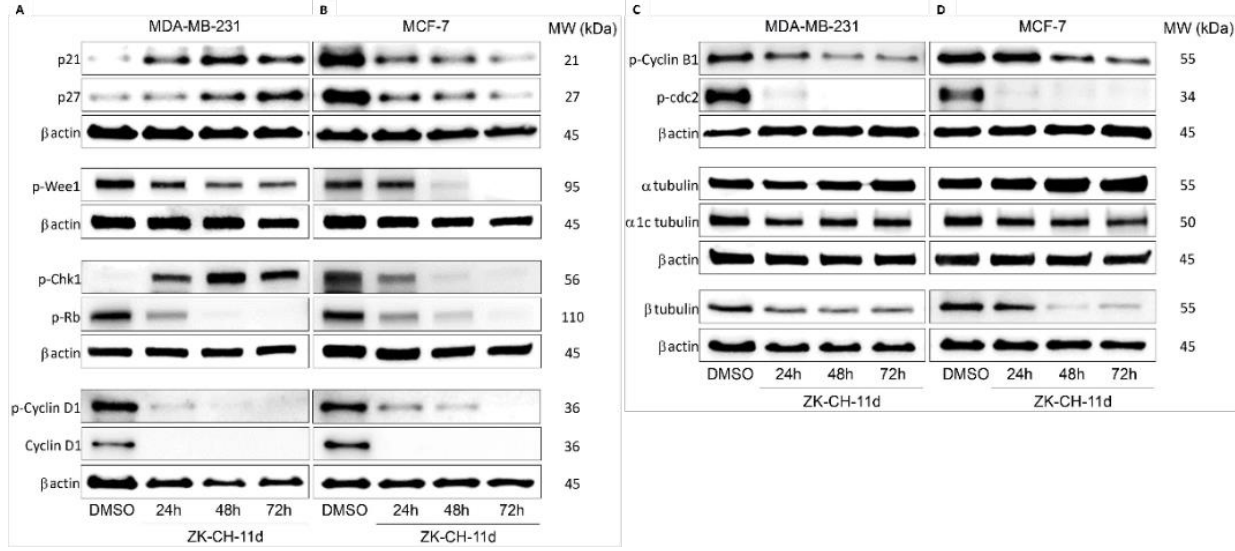
Figure 6. Western blot analysis of cell cycle proteins and related proteins and tubulins in MDA-MB- 231 ( A , C ) and MCF-7 ( B , D ) cells after treatment with chalcone ZK-CH-11d for 24, 48, and 72 h. The p27 Kip1 protein, together with p21, belongs to a family of cyclin-dependent kinase inhibitors whose role is to arrest the cell cycle. Its functions include the regulation of cell proliferation, cell differentiation, and apoptosis. Figure 6A shows that chalcone ZK-CH-11d had a significant effect on upregulation of p27 in MDA-MB-231 cells, but in MCF-7 cells caused a decrease in the expression of this protein in a time-dependent manner (24, 48, and 72 h) (Figures 6A,B and Figure